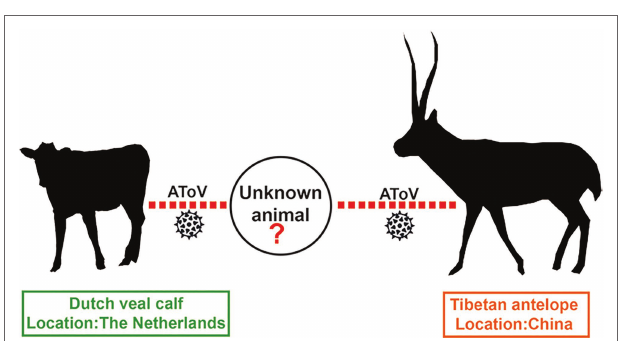
FIGURE 9 | Possible transmission model of AToV. Red dotted lines indicated unknown routes of transmission for AToV among Tibetan antelope, unknown animal, and Dutch veal